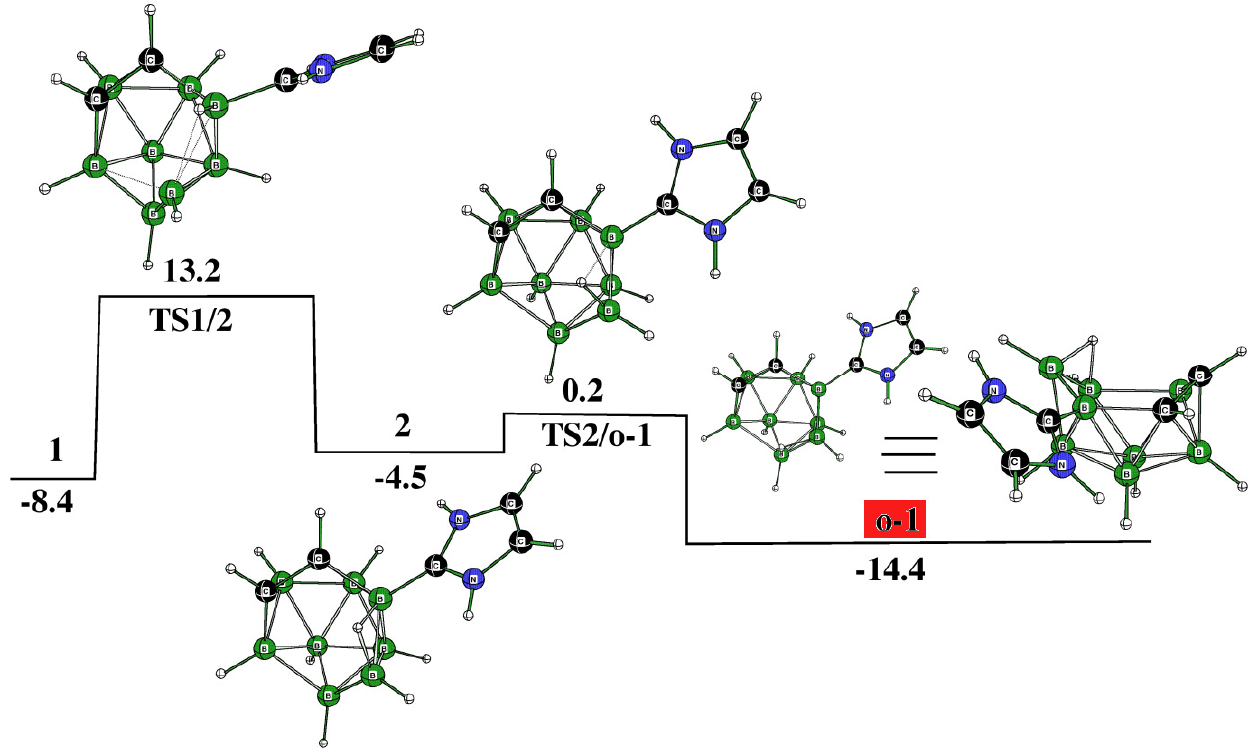
Figure 2. Relative free energies (kcal.mol − 1 ) of the individual stationary points on the potential energy surface (PES) of the formation of o ‐ 1 (see Tables 1 and S1 and Section 3 for details).